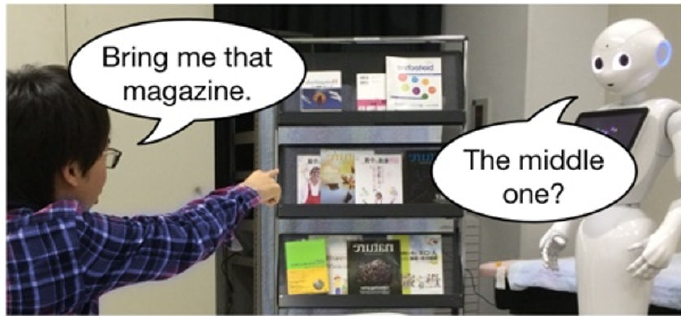
Figure 1. A robot recognizes an object to which a user